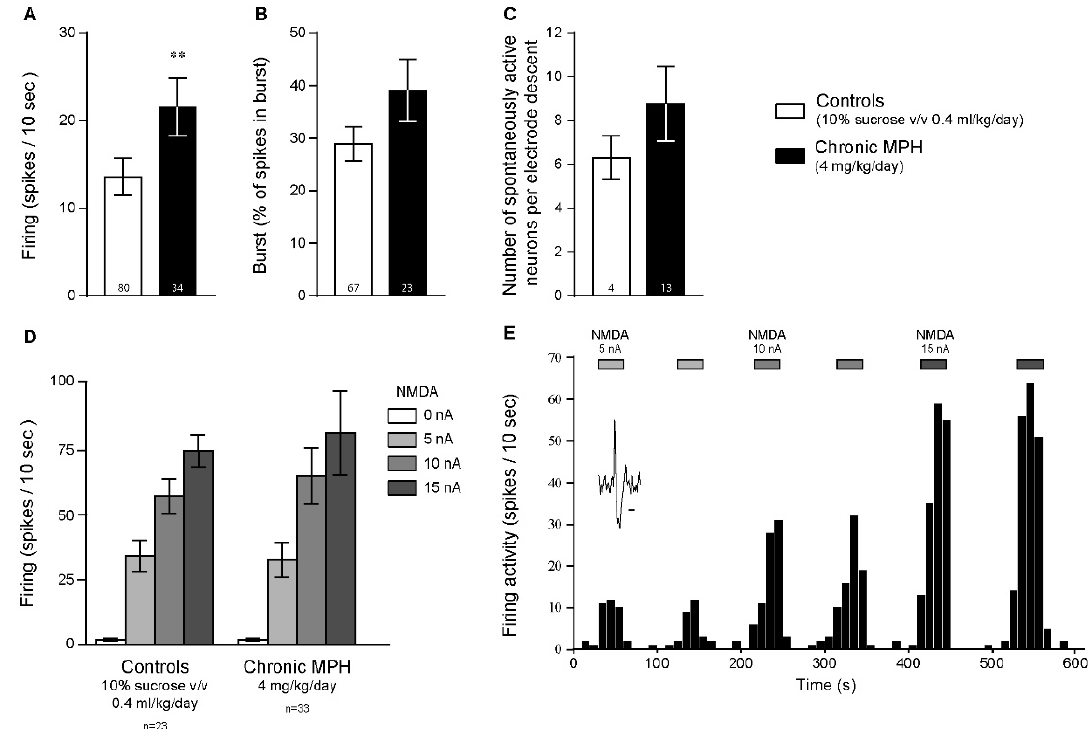
Figure 2. Chronic MPH treatment increases the firing activities of PFC pyramidal neurons, without altering NMDA neurotransmission. Chronic MPH (4 mg/kg/day/animal for 15 consecutive days followed by a 28-day washout period) significantly increased the firing discharges of PFC pyramidal neurons ( A ) but had no influence on the bursting discharges of these neurons ( B ) or the total number of spontaneously active neurons encountered during electrode descent ( C ). ** p < 0.01 vs. controls, unpaired t -tests. ( D ) Chronic MPH treatment did not influence the responses of PFC pyramidal neurons to locally applied NMDA (5–15 nA, 30 mM NMDA solution), via micro-iontophoresis (F (3,162) = 0.26, p > 0.8). ( E ) Single-unit extracellular electrophysiological recording time course example, where NMDA increased the firing activities of a PFC pyramidal neuron in a current-dependent manner. A typical action potential waveform in such neurons is also illustrated. The horizontal bar represents 1 ms. n values are given for each group and represent number of neurons recorded, except in ( C ) where n values represent number of electrode descents.